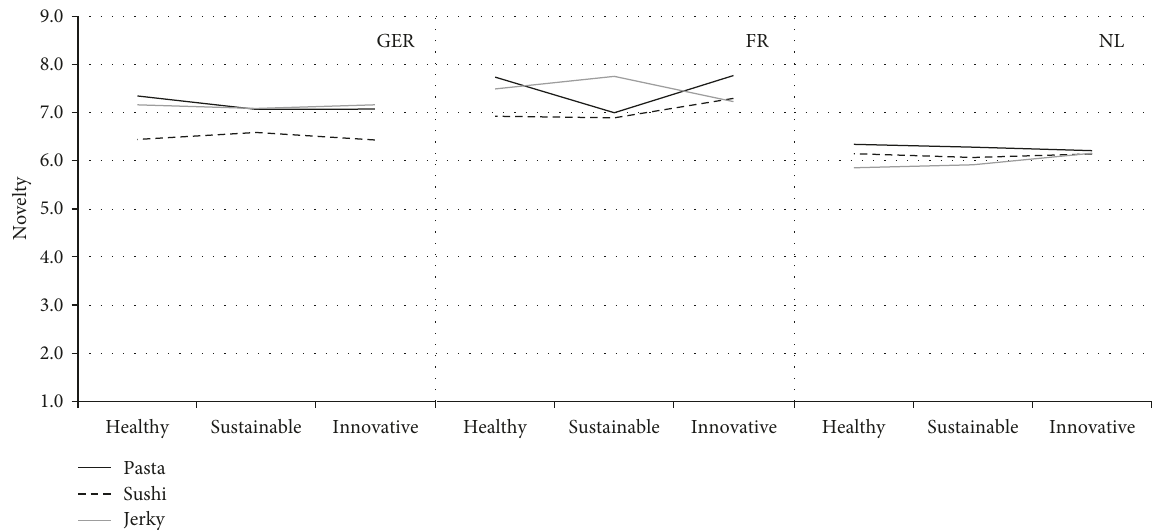
Figure 5: Novelty (9-point scale (“not at all novel” (1) to “very novel” (9))) as a function of product, benefit, and country (marginal means from M3).